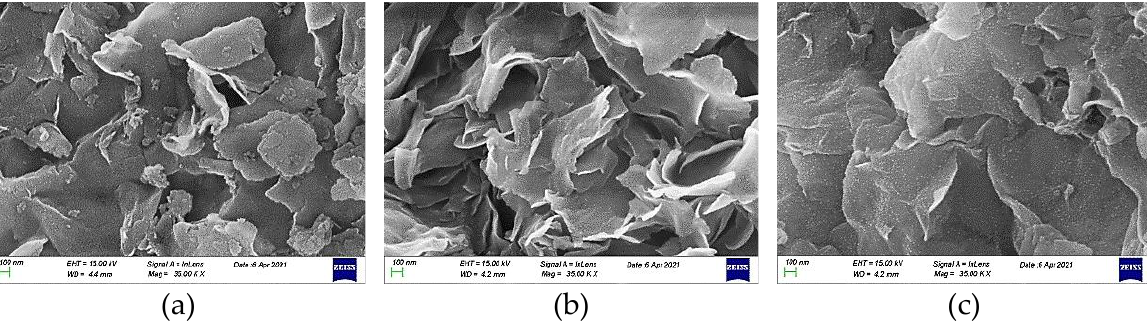
Figure 7. Representative SEM images of the samples ( a ) MM; ( b )20Ni/MM(H) and ( c ) 20Ni2Mo/MM(H). (magnification 35.000 KX).